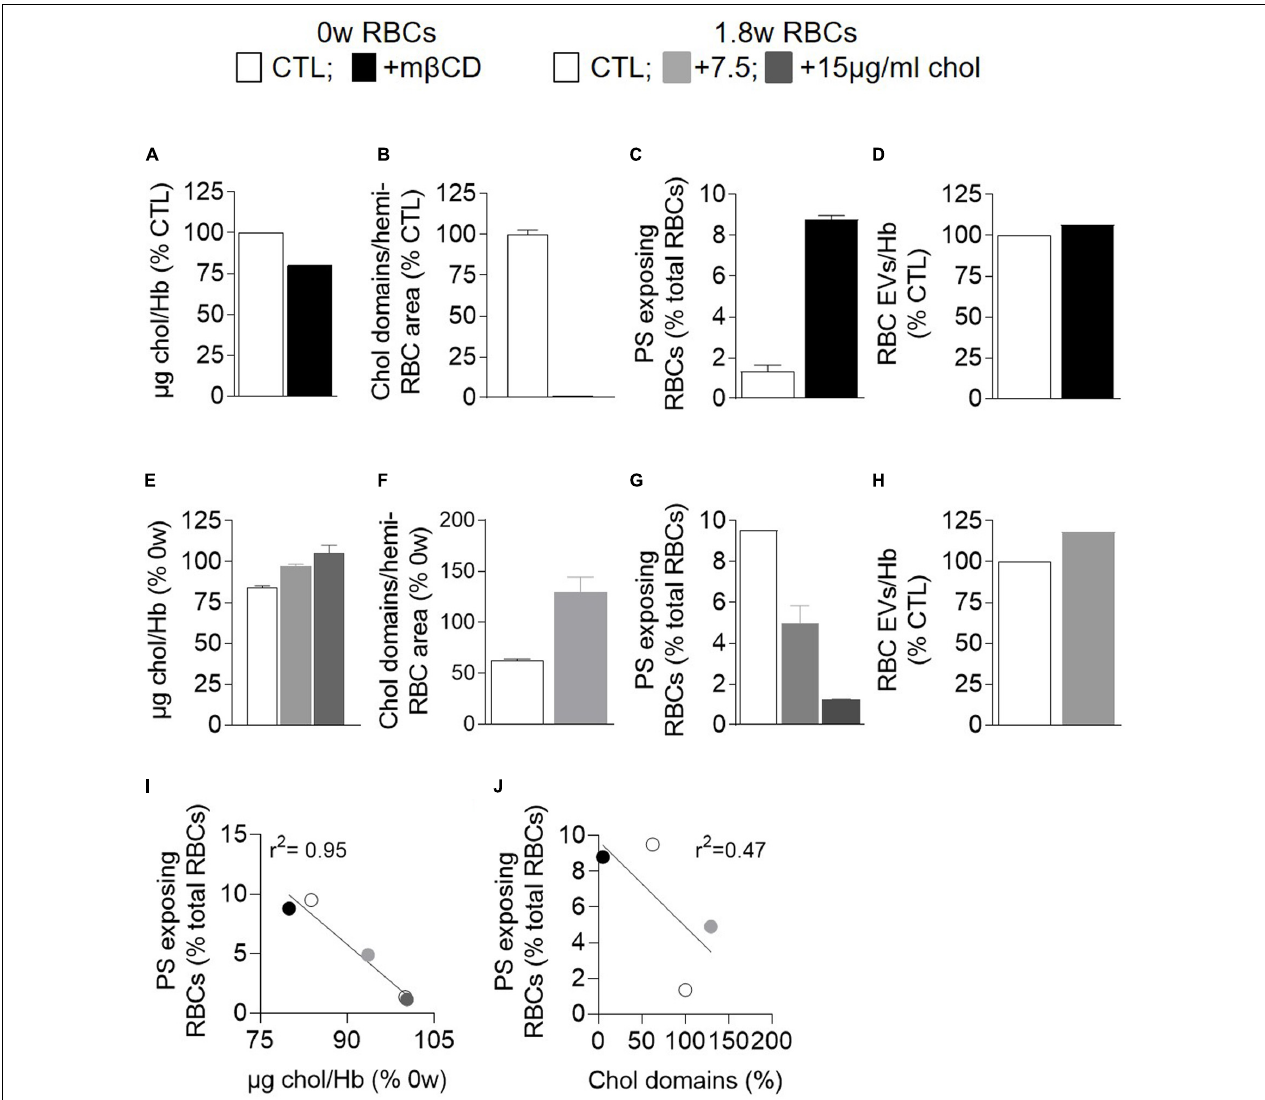
FIGURE 9 | Modulation of the membrane cholesterol content correlates with the extent of PS surface exposure but not with the abundance of RBC EVs. Fresh RBCs were depleted in membrane chol with methyl- β -cyclodextrin (m β CD; A–D,I,J ; black) whereas 1.8 week-stored RBCs were repleted with water-soluble chol at 7.5 or 15 µ g/ml ( E–J ; light and dark gray). All RBCs were then analyzed for their chol content (A,E) , chol-enriched domain abundance (B,F) , PS surface exposure (C,G), and EV release (D,H) . (A,E) Chol content determined as in Figure 4A . Data are from Carquin et al. (2015) in (A) and are expressed as % of fresh untreated RBCs in (E) (means ± SD of 2 independent experiments). (B,F) Abundance of chol-enriched domains. Data were determined at in Figure 5 and are expressed in % of fresh untreated RBCs (means ± SD of 2 experiments). (C,G) PS exposure determined as in Figure 4G . Data are means ± SD of 2 independent experiments in (C) and of 1 experiment in duplicates in (G) . (D,H) EV released by RBCs determined as in Figure 8E . Data are expressed in % of untreated RBCs. (I,J) Correlation between PS surface exposure and the chol content (I) or the abundance of chol-enriched domains (J)